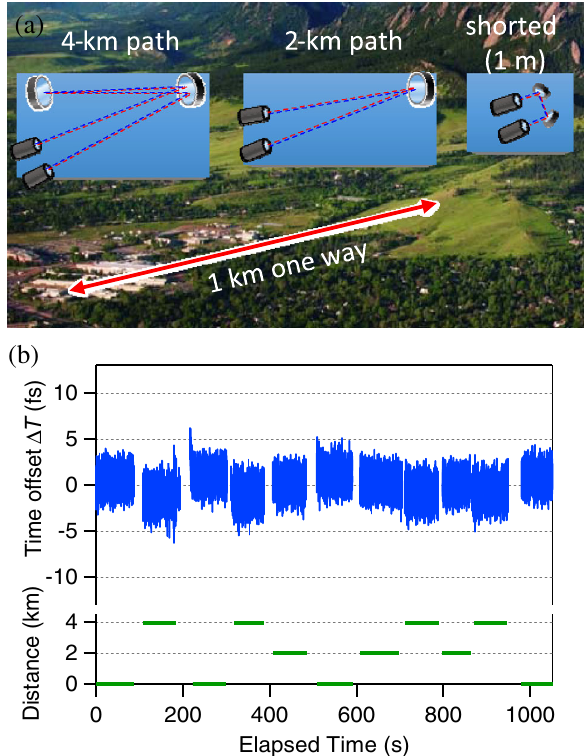
FIG. 7. (a) The link traverses the National Institute of Standards and Technology (NIST) campus over 1-m, 2-km, and 4-km distances with the latter achieved by a double pass between two flat mirrors. (b) The out-of-loop time offset Δ T (blue) as the link distance (green) is changed in real